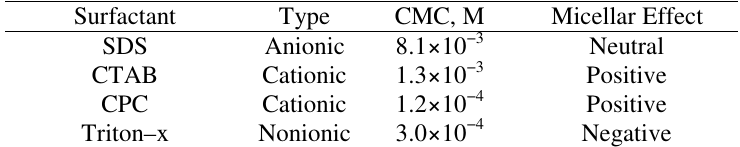
Table 1. Surfactant tested for enhancment of analytical signal of methyl red - BrO 3- - phenylhydrazine system